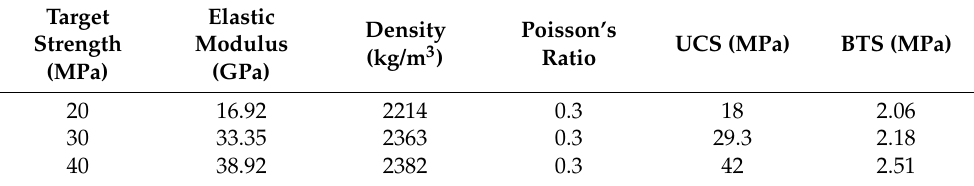
Table 1. Physical and mechanical properties of model rocks.